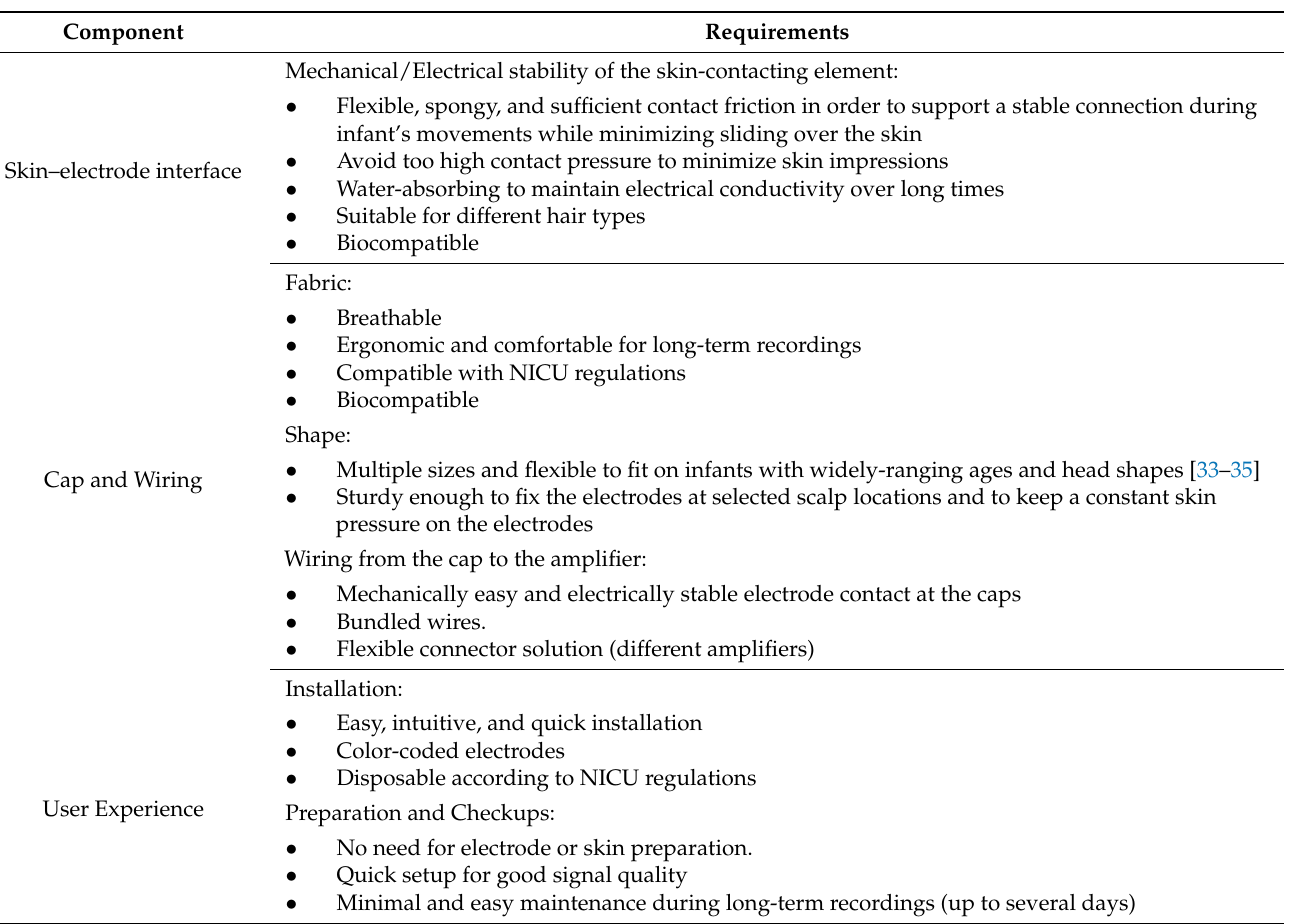
Table 1. Requirements for components of the EEG cap.